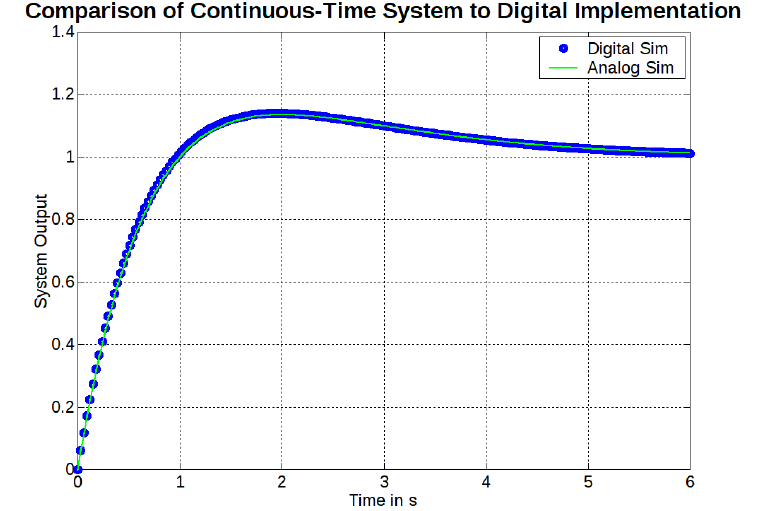
Figure 22. Comparison of continuous-time system to digital implementation.